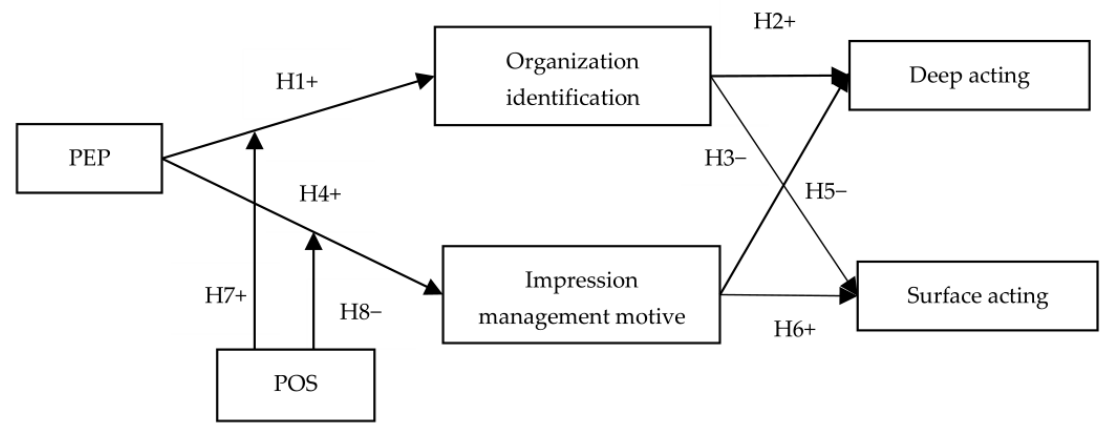
Figure 1. Conceptual